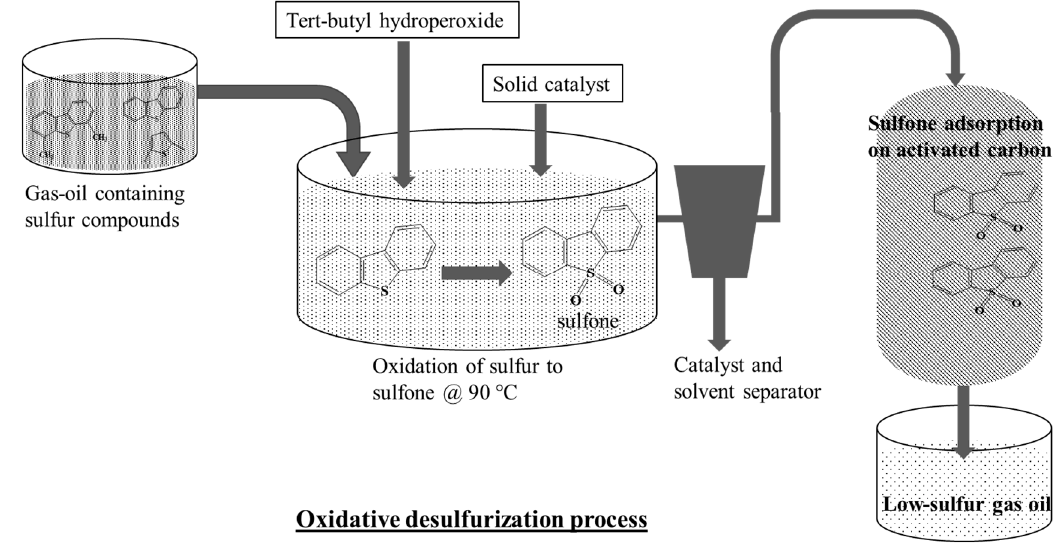
Figure 1. Schematic for Oxidative desulfurization process.